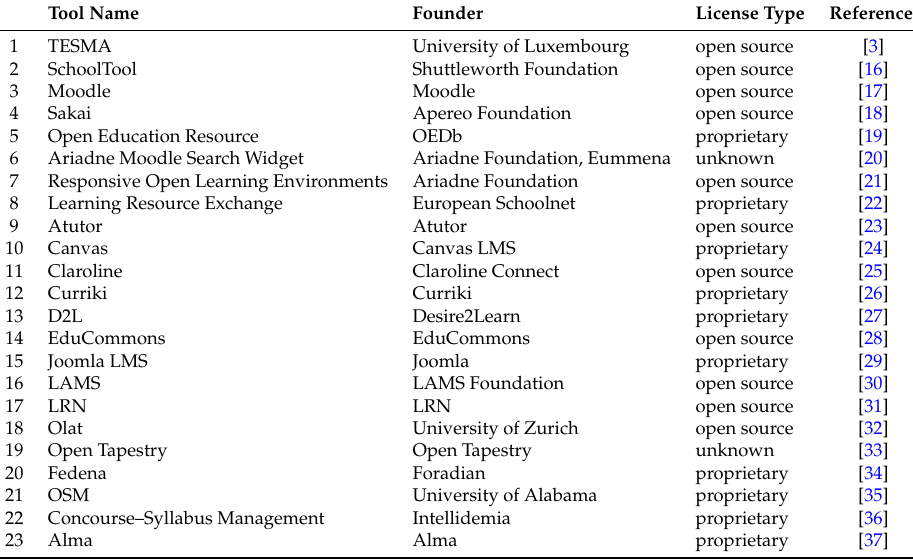
Table A1. List of surveyed tools during the secondary